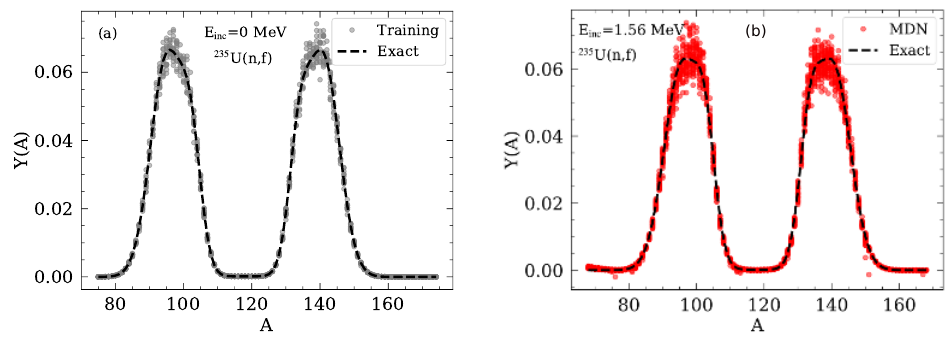
Figure 3. Mass yields for 235 U(n,f). (a) Training set at E inc = 0 MeV (thermal) compared to the exact parameterization from CGMF and (b) MDN prediction for E inc = 1 . 56 MeV compared to the exact CGMF